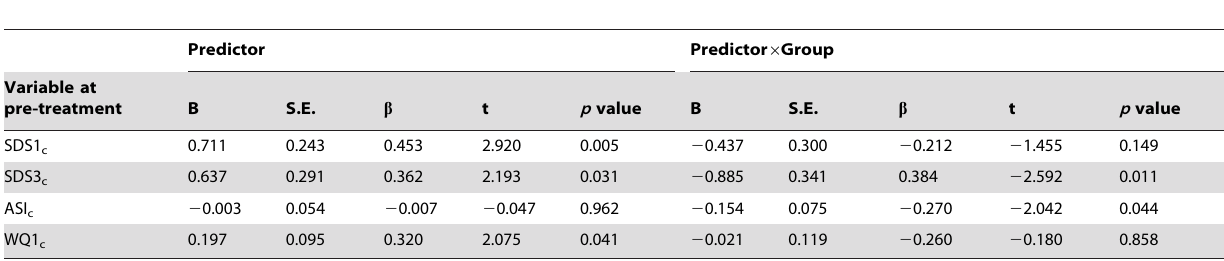
Table 2. Initial significant models with PDSS scores at six-month follow-up as dependent variable.